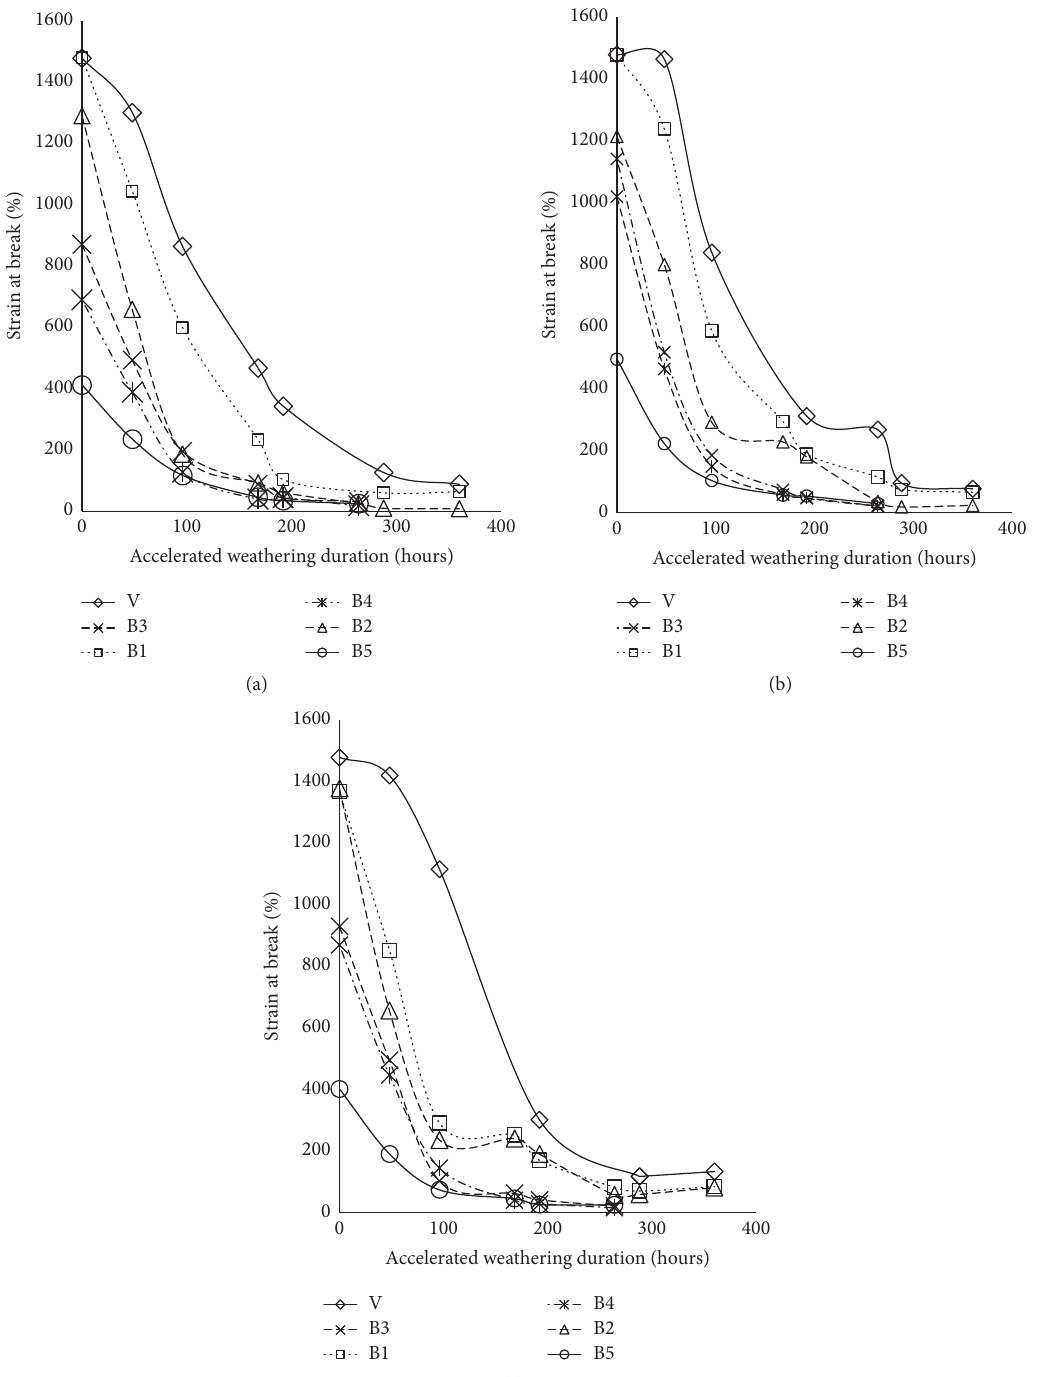
waste materials contain. The transmission measured showed the highest change among samples processed with a DHT equal to 195 ∘ C due to higher temperature profile developed between cooling and heating cycles at compounding